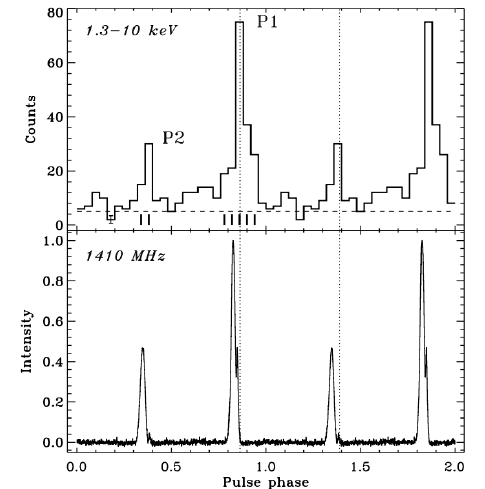
Figure 2. The X-ray pulse profile in the full MECS X-ray band 1.3–10 keV and two sub-